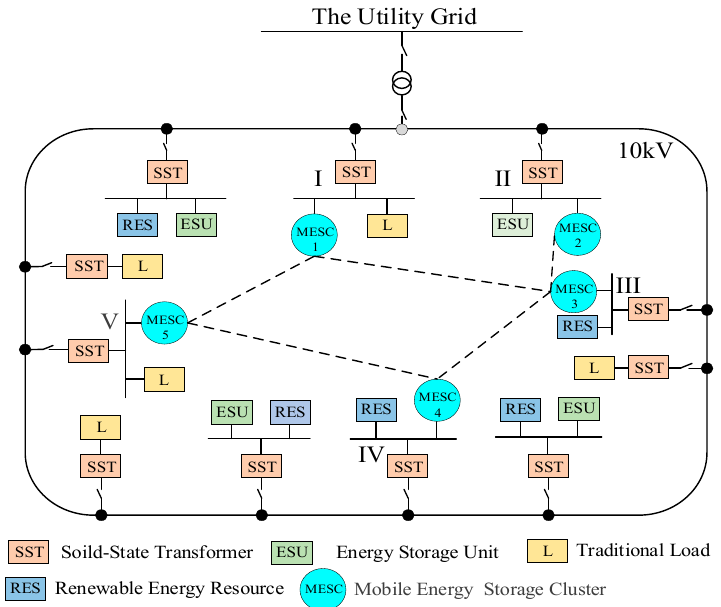
Figure 4. Block diagram of the FREEDM microgrid system. Table 1. The number and type of electric vehicles (EVs) connected to different buses.